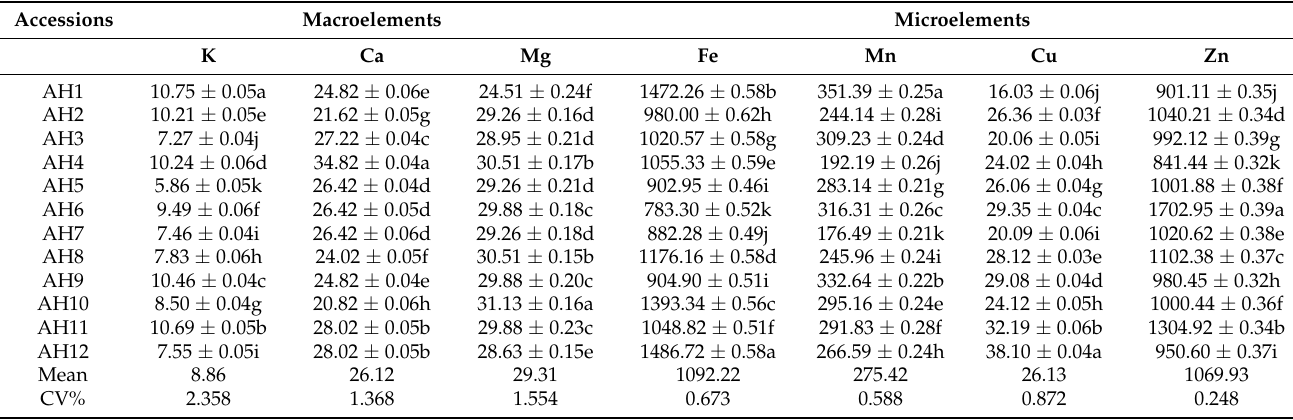
Table 2. Minerals [Macroelements and microelements (mg g − 1 DW and µ g g − 1 DW)] of 12 slim amaranth